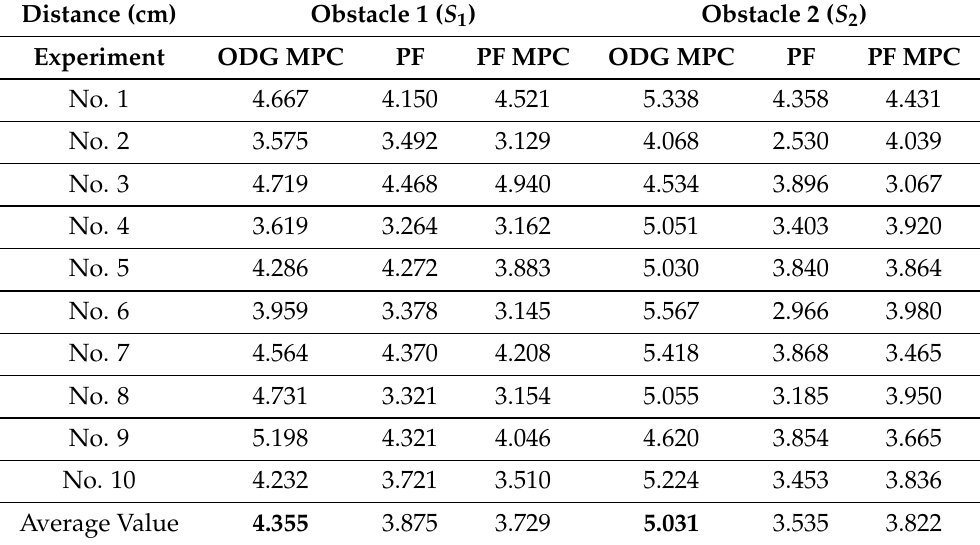
Table 13. Results of the minimum distance from Scenario 3 for one dynamic obstacle and one static